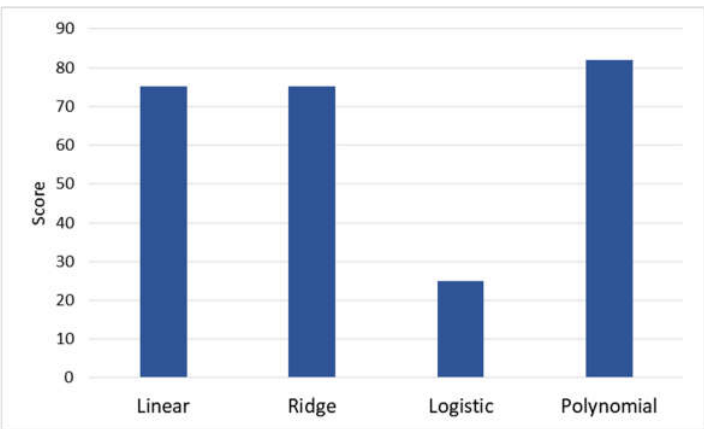
Figure 4. Comparison of algorithms for determining permissible ranges of variable values.